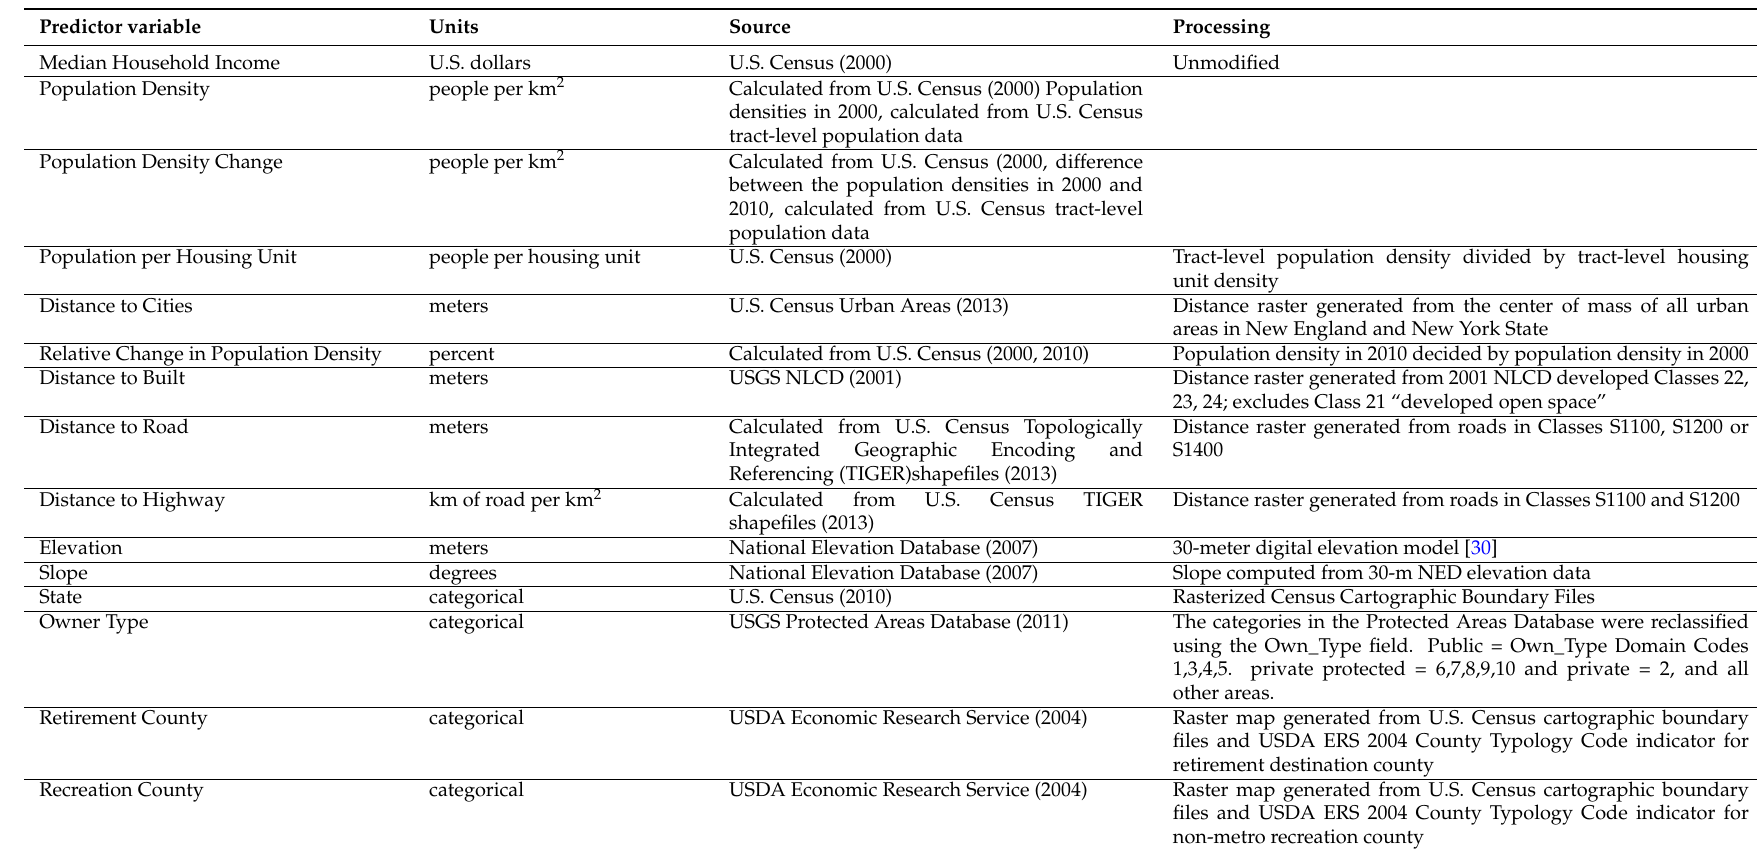
Table 1. Predictor